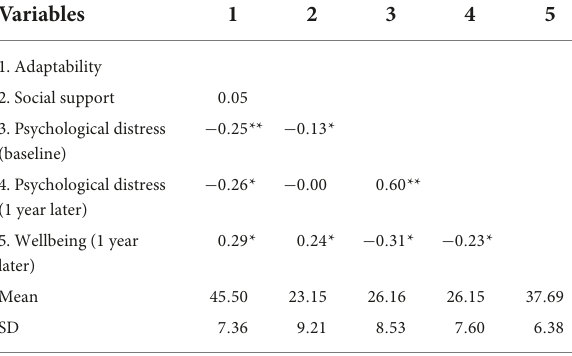
TABLE 1 Means, standard deviations, and correlations between key variables.